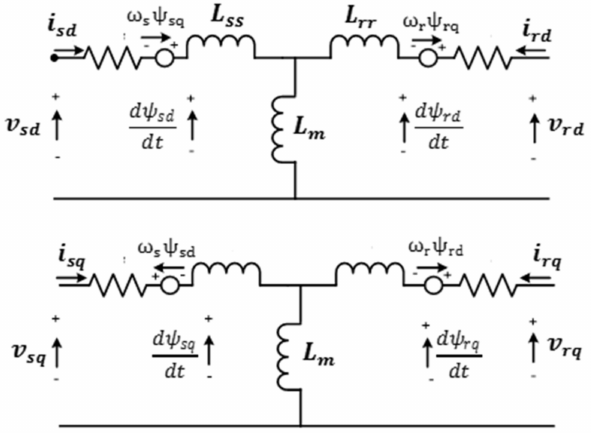
Figure 4. Equivalent circuit of d − q axis of DFIG rotor